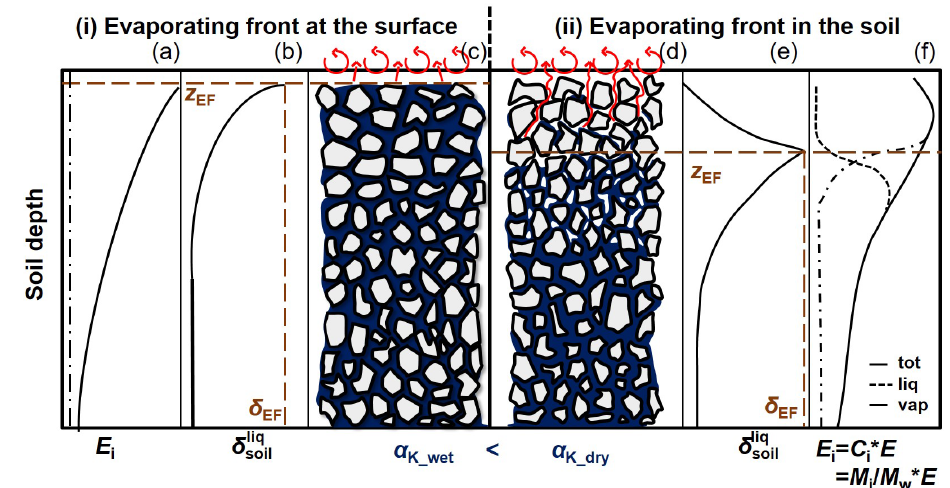
Figure 5. Effect of the water status of the soil, i.e. the positioning of the evaporating front (EF, dashed line), on the value of the kinetic fractionation factor ( α K ). Panels (a–c) refer to the situation of a saturated soil (subscript “wet”) where the EF is located at the soil surface; panels (d–f) refer to a dry soil with the EF below the soil surface. The corresponding soil water total (tot; solid line), liquid (liq; dotted line), and vapour (vap; dash-dotted line) isotopic flux profiles ( E i , ML − 3 ) (a,f) ; soil liquid isotopic composition profiles (b,e) are reported as well. Adapted from Braud et al.